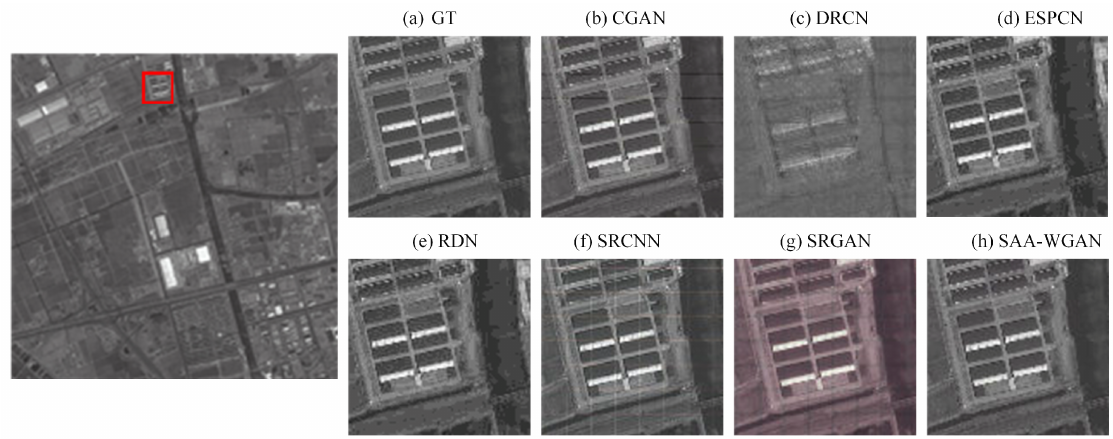
Figure 9. SR results from DOTA datasets (scale =